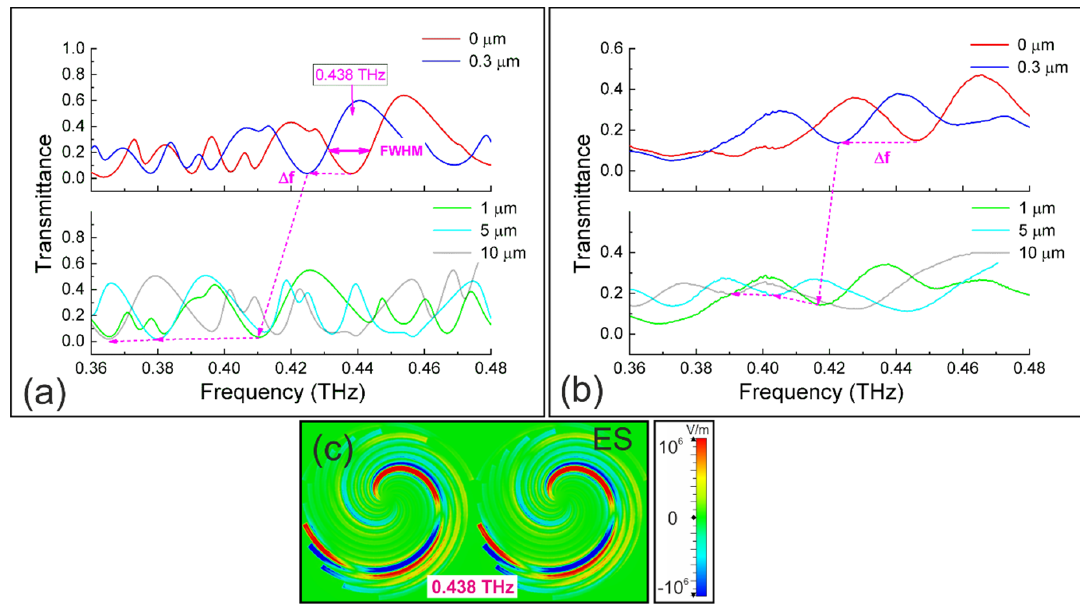
Figure 6. Transmittance spectra of the closely spaced ( p = 408 µm) spiral disks with centers shifted at δ r = 35 µ m, covered by photoresist films of di ff erent thicknesses: ( a ) the numerical simulations; ( b ) the experiments; ( c ) the E Z -field distribution at resonance (0.438 THz). Normal incidence ( θ = 0 ◦ ), E || X